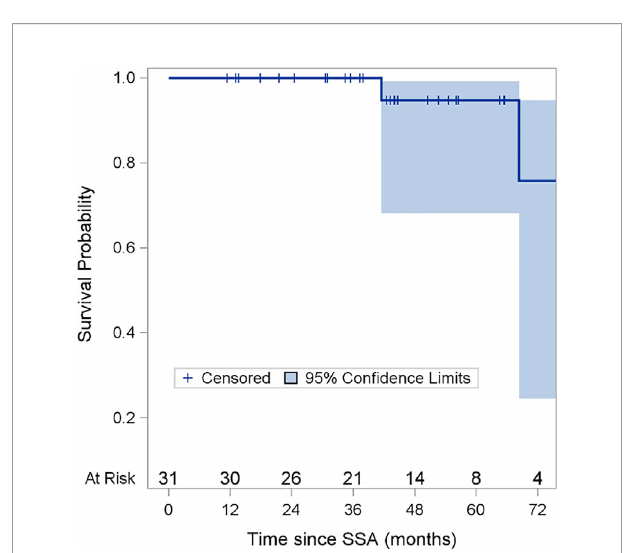
FIGURE 3 | Overall Survival (OS) in the Entire